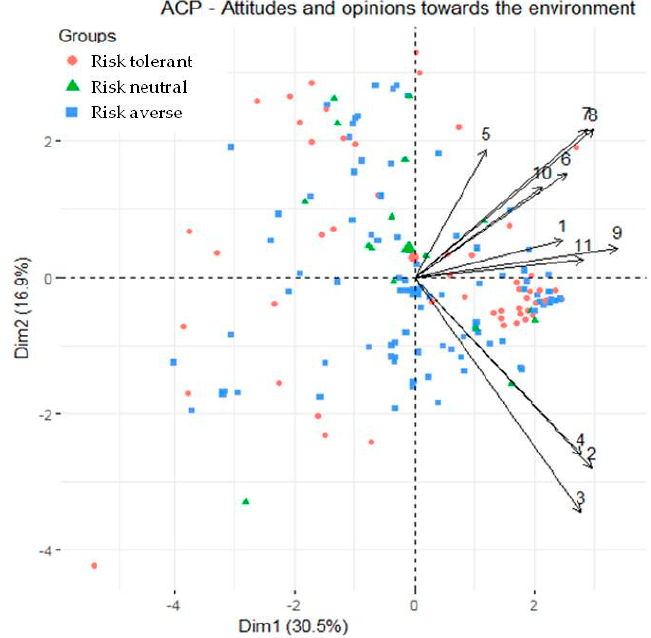
Figure 5. Distribution of farmers, interviewed according to their environmental opinions. ( 1 ) A global ecological crisis is exaggerated; ( 2 ) The balance of nature supports the impact of industrialized countries; ( 3 ) Humans may be able to control nature; ( 4 ) Human ingenuity ensures that the earth is not uninhabitable; ( 5 ) The interference of the human being in nature has disastrous consequences; ( 6 ) The human being seriously abuses the environment; ( 7 ) The balance of nature is delicate and easily alterable; ( 8 ) We are approaching the limit number of people that the earth can hold; ( 9 ) The earth has limited resources; ( 10 ) The land has abundant resources; we just have to learn how to exploit them; ( 11 ) Sustainable development needs a balanced situation.